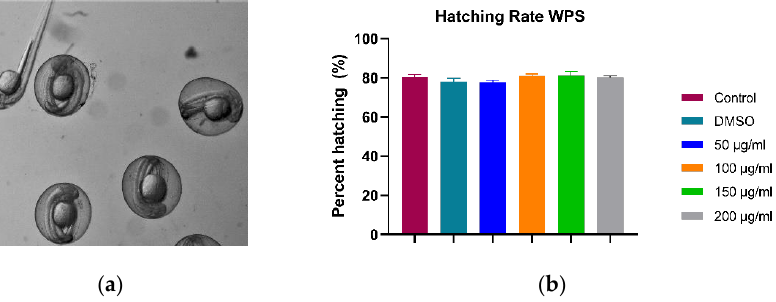
Figure 3. The effect of WPS on the hatching of zebrafish embryos at 48 hpf. ( a ) Representative image of embryos displaying hatched and unhatched embryos at 48 hpf. ( b ) The effect of WPS on the hatching percentage of the experimental groups at 48 hpf. All data are presented as mean ± SEM (20 embryos were used in each group; the experiment was performed in triplicate). One-way ANOVA with Sidak post hoc test was used to compare the differences between groups.